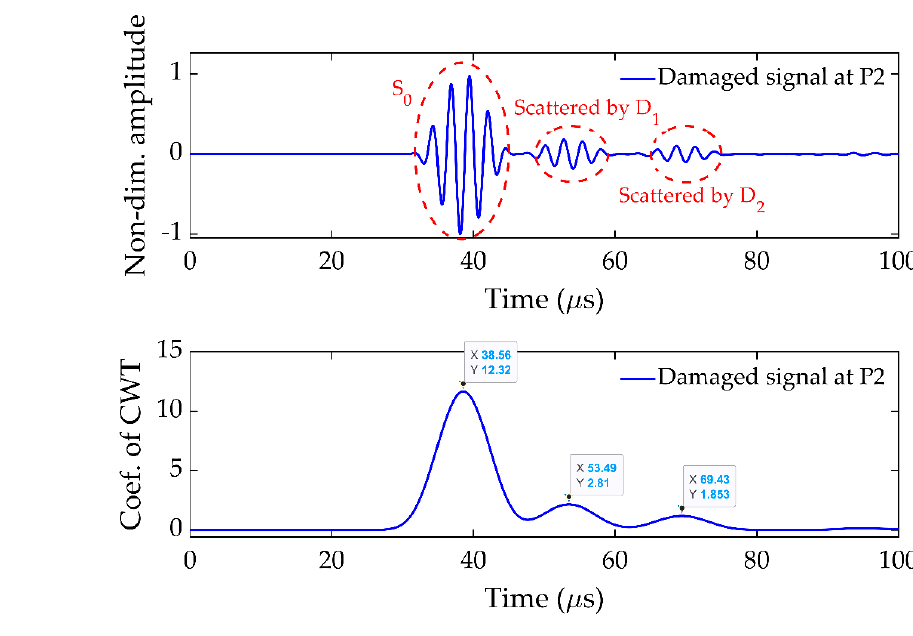
Figure 14. A cell with multiple damages of different sizes in one subcell.